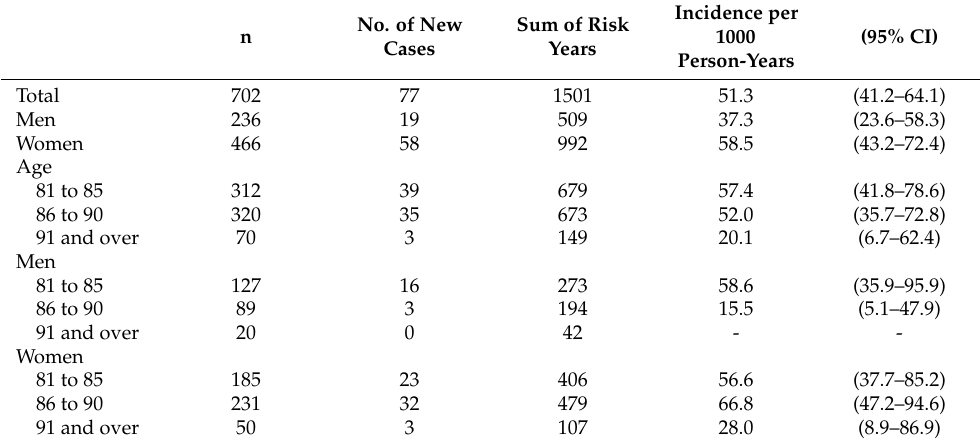
Table 2. Age- and gender-specific incidence of anxiety symptoms (GAI < 3 at FU5 and ≥ at FU6 and/or